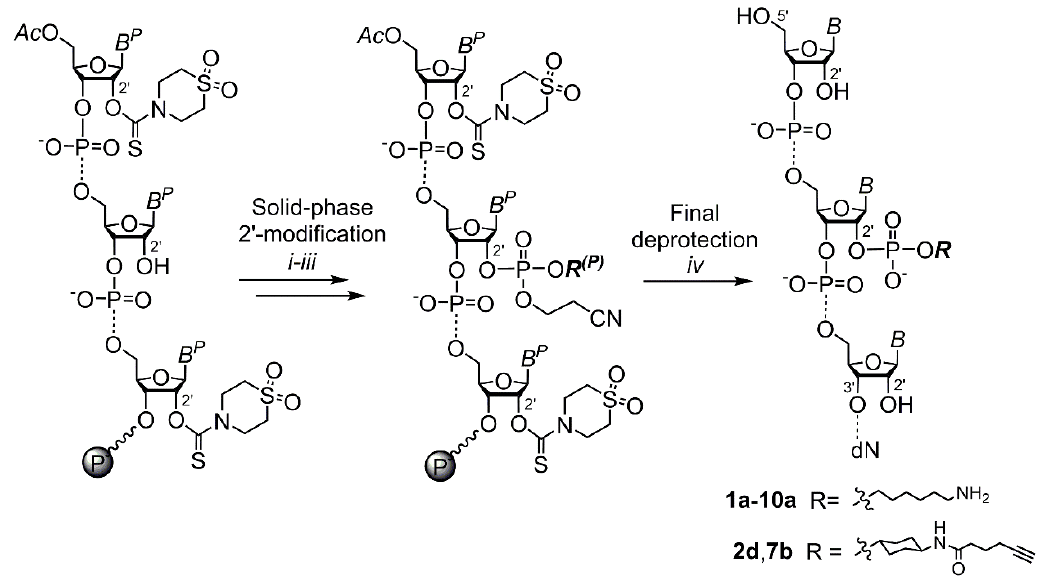
Figure 2. 2’ functionalization of RNA via formation of a 2’-phosphodiester linkage. Solid-phase 2’ modification: i) modifying ( R ) phosphoramidite, 5-(ethylthio)-1 H -tetrazole, CH 3 CN abs., 10 min; ii) I 2 , THF, pyridine, H 2 O; and iii) CHCl 2 COOH, CH 2 Cl 2 . Final deprotection: iv) NH 2 CH 2 CH 2 NH 2 abs, 25